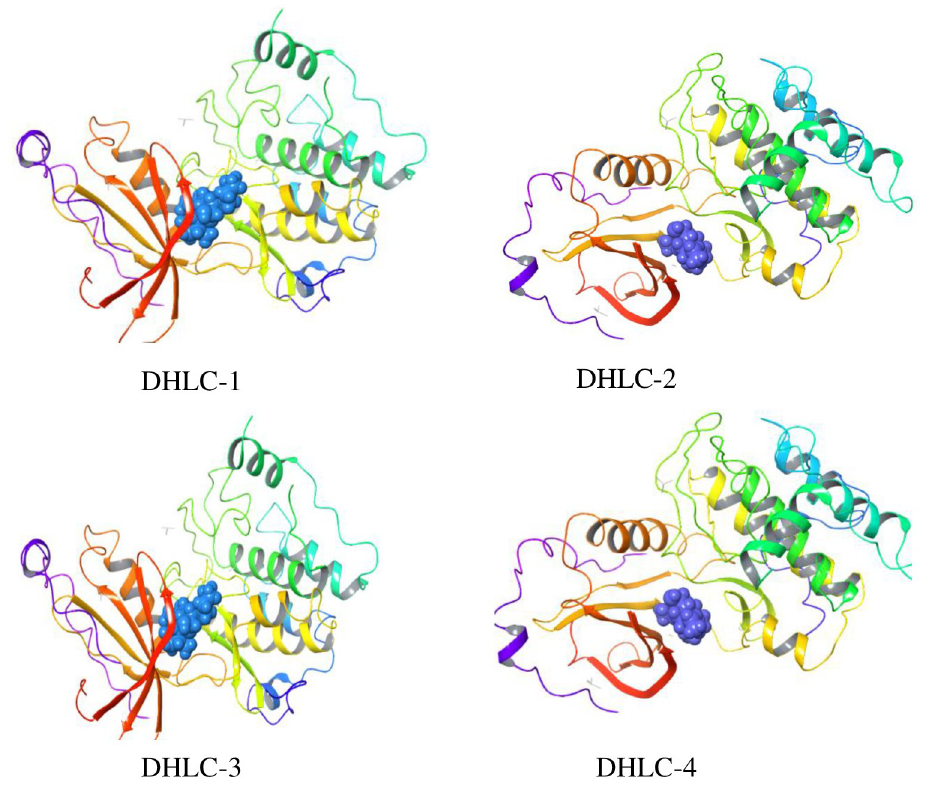
Fig 5. Best binding poses of 13-amino derivatives (DHLC-1-4) with 1ZRZ.